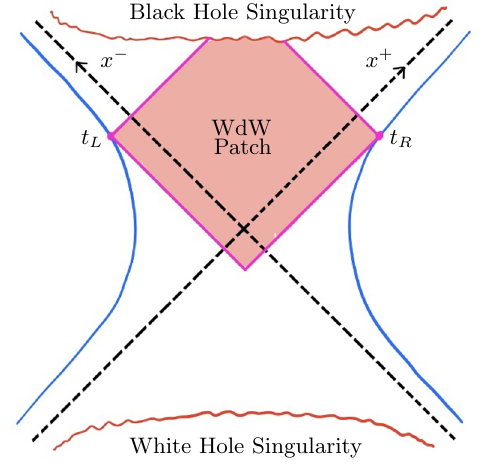
Figure 4 . Kruskal diagram of eternal black hole. A symmetric WdW patch is presented. Color coding agrees with previous